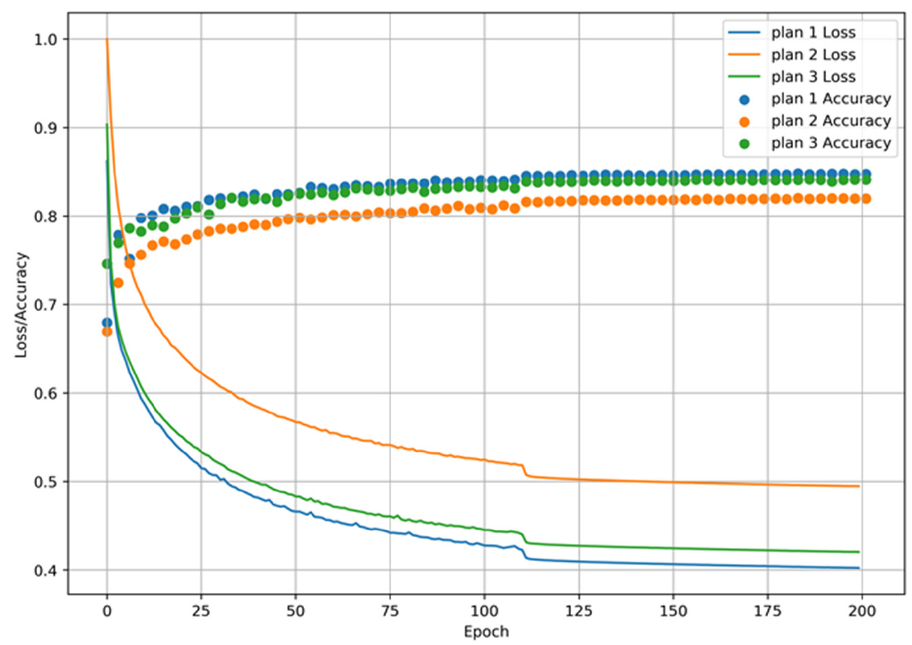
Figure 9. Variation in the loss and accuracy of training.